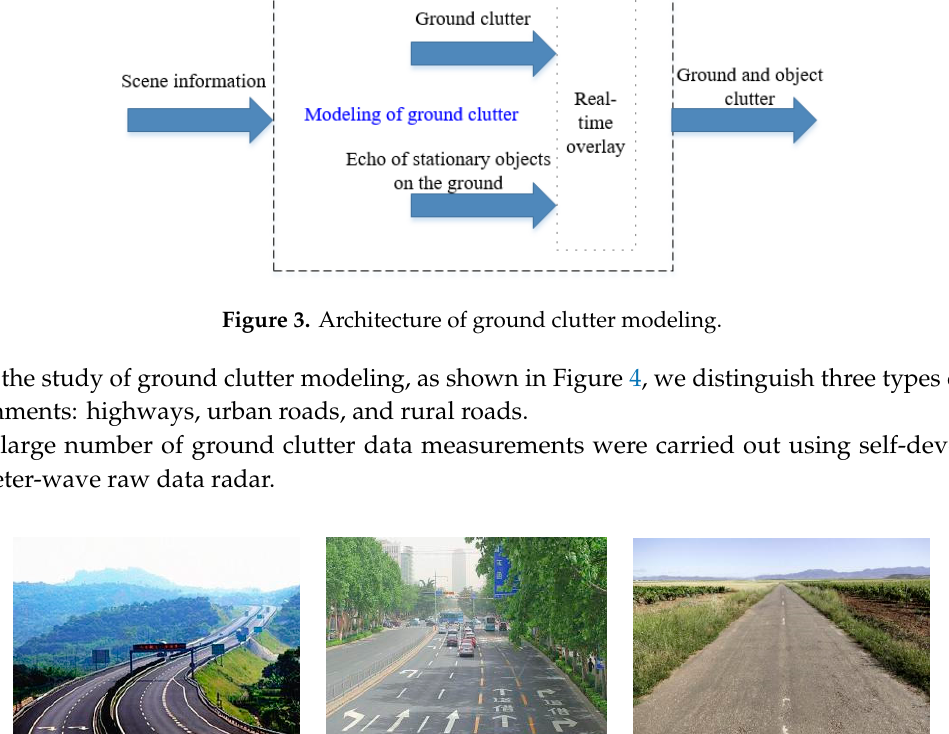
Figure 4. Road environment for three types of traffic: (a) Highways; (b) Urban roads; (c) Rural roads.